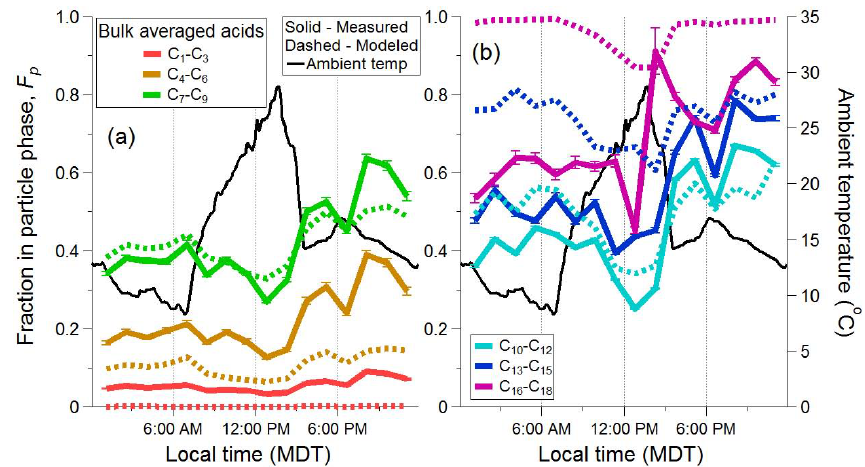
Fig. 9. Time series of F p for C 1 –C 18 bulk-averaged acids on 26 August 2011. Also shown are model results where excess oxygen is added as a hydroxyl group. Data and model results are further averaged into different carbon number bins.